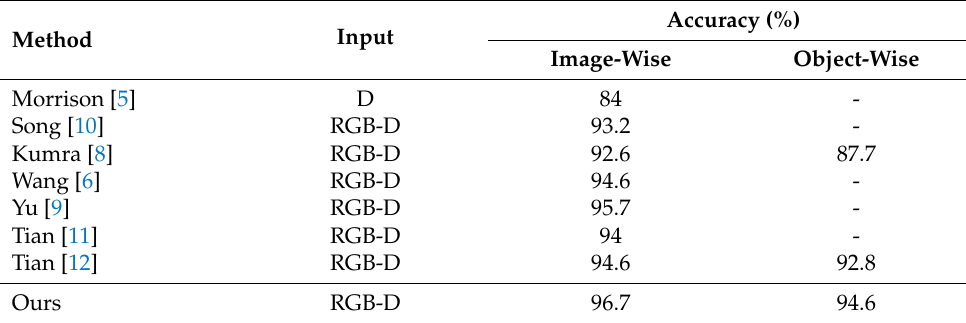
Table 3. Grasp detection results of different algorithms on Jacquard